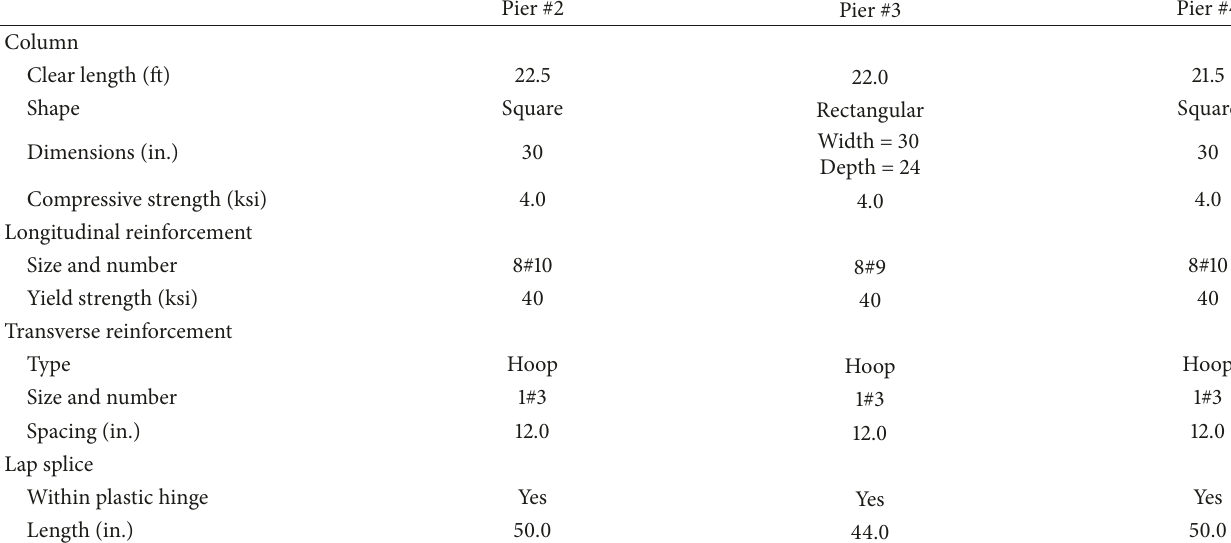
Table 4: Bridge #3-E columns’ geometric properties and reinforcement details.